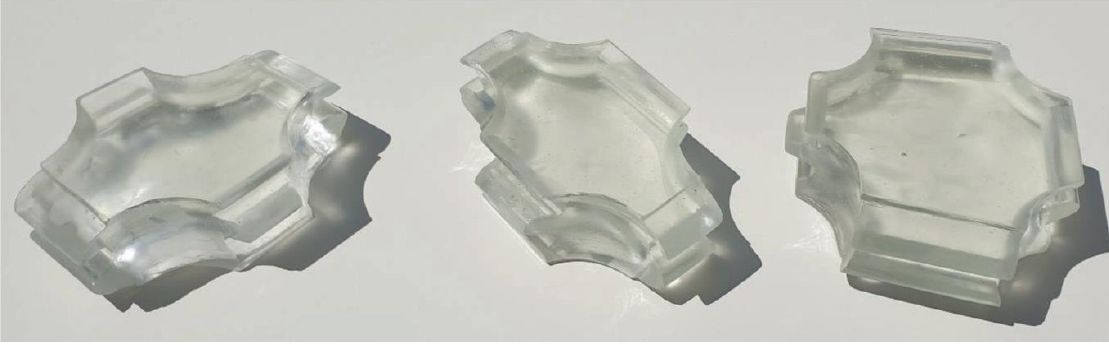
Fig. 18 Resulting cast glass components, made by lost-wax technique.